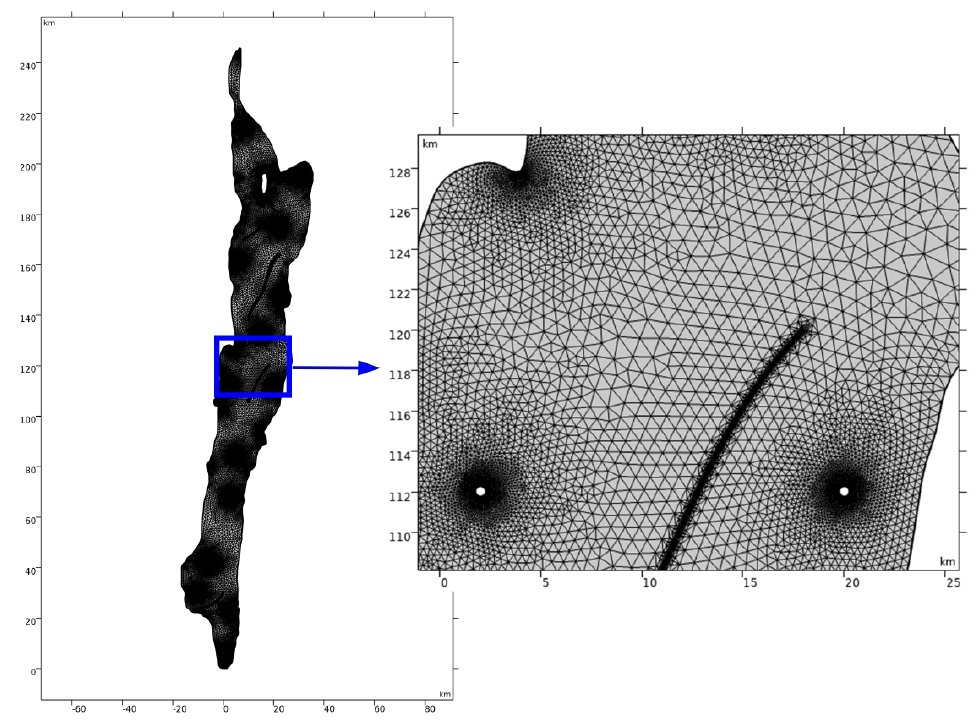
Figure 12. Overview and close-up of the elements distribution over the domain for the finer mesh.